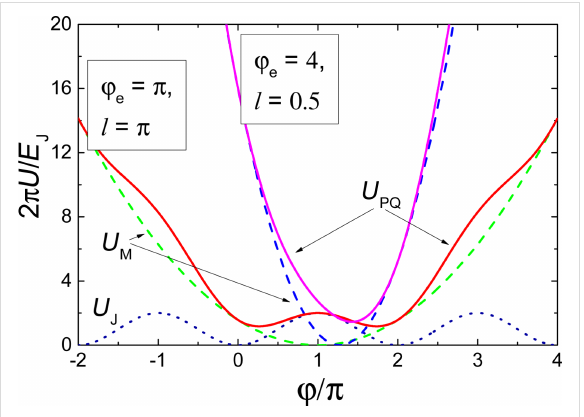
Figure 11: Potential energy of a parametric quantron U PQ (Equation 2) (solid lines) and its terms: magnetic energy U M (dashed lines), and Josephson junction energy U J (dotted